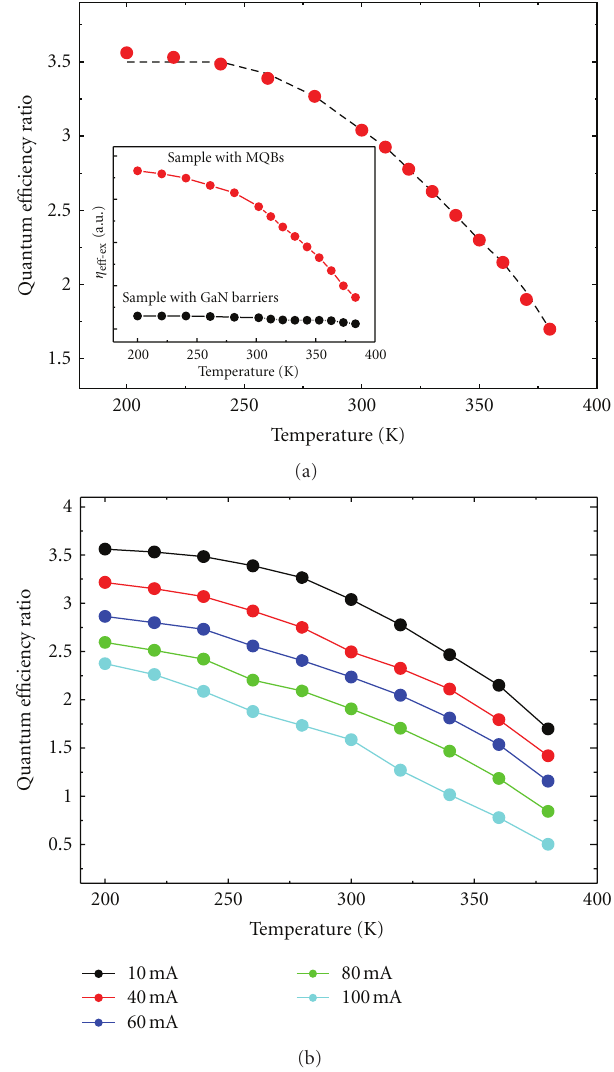
Figure 7: (a) Temperature-dependent EL quantum e ffi ciency ratio of the sample with MQBs to the sample with GaN barriers. The inset shows the dependence of the EL e ffi ciency on temperature for the samples. The driving current is 10mA. (b) Temperature-dependent EL quantum e ffi ciency ratio of the samples in the driving current range 10 to 100